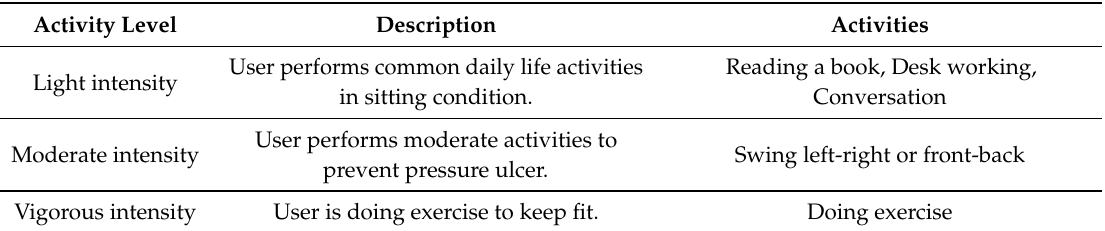
Table 3. Categorization of different activity levels of wheelchair users.